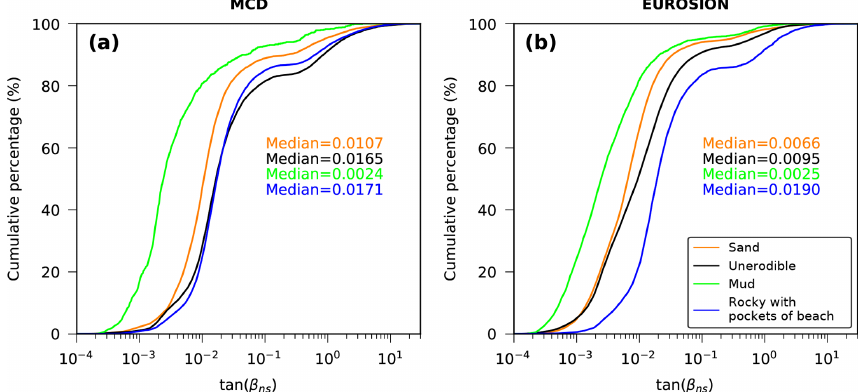
Figure 7. Cumulative probability distribution of nearshore slopes per coastal type for the (a) MCD dataset and (b) EUROSION dataset. The median values per coastal types are plotted with their respective colors as indicated in the legend. Note that the x axis is plotted on a log